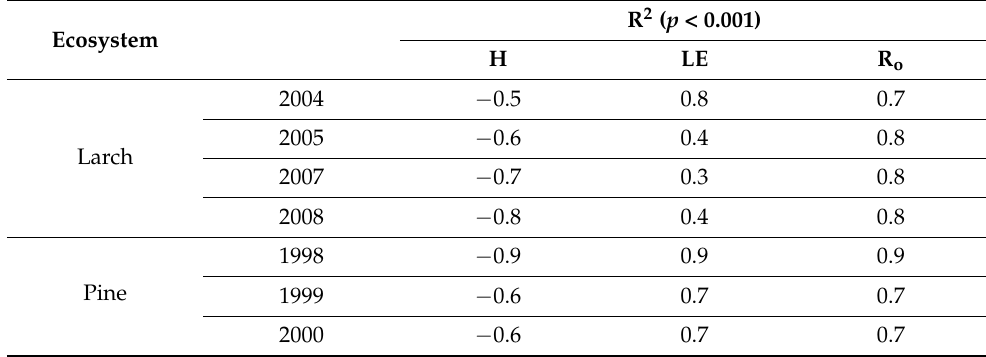
Table 3. Relationships between CO 2 exchange and energy budget components for the growing season in the Gmelin larch and pine